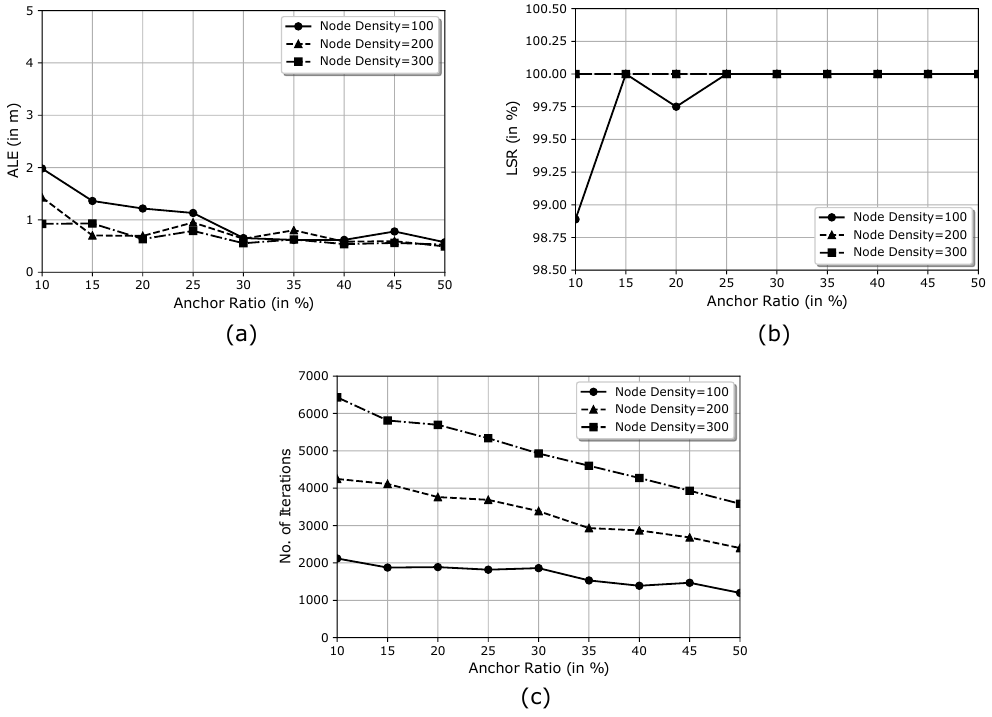
Figure 7. Effect of anchor ratio variation on the performance of the proposed ECS algorithm. ( a ) The effect of anchor ratio variation on ALE. ( b ) The effect of anchor ratio variation on LSR. ( c ) The effect of anchor ratio variation on the performance of the proposed ECS